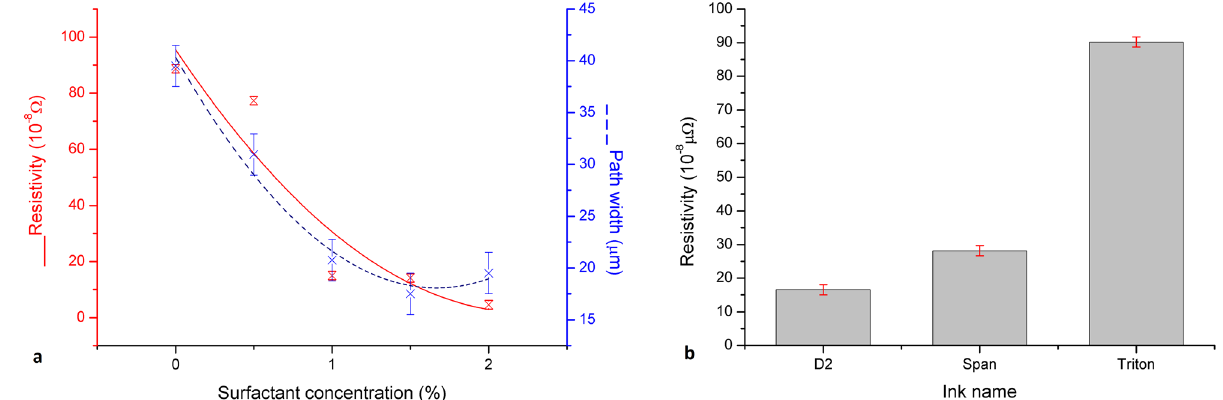
Figure 8. Charts of test results ( a ) computed mean resistivity and the path width for surfactant concentration test—Inks containing AKM-0531 as the surfactant in concentrations 0.5 wt.% (S0.5), 1 wt.% (S1), 1.5 wt.% (S1.5) and 2 wt.% (S2); ( b ) computed mean resistivity for surfactant type test—nks containing 2 wt.% of Capstone (CA)—not conductive, Triton X100 (TR), AKM-0531 (D2), and Span 85